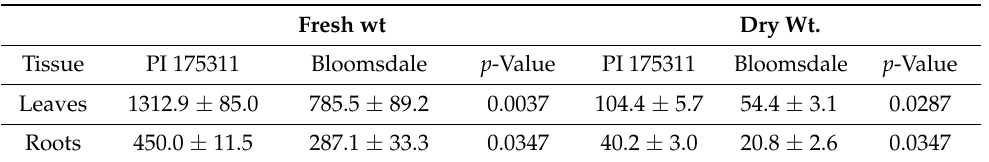
Table 1. Oxalate content (mg/100 g) in leaves and roots of PI 175311 and Bloomsdale ( n = 5; Mean ± Std Error). Fresh wt Dry Wt. Tissue PI 175311 Bloomsdale p